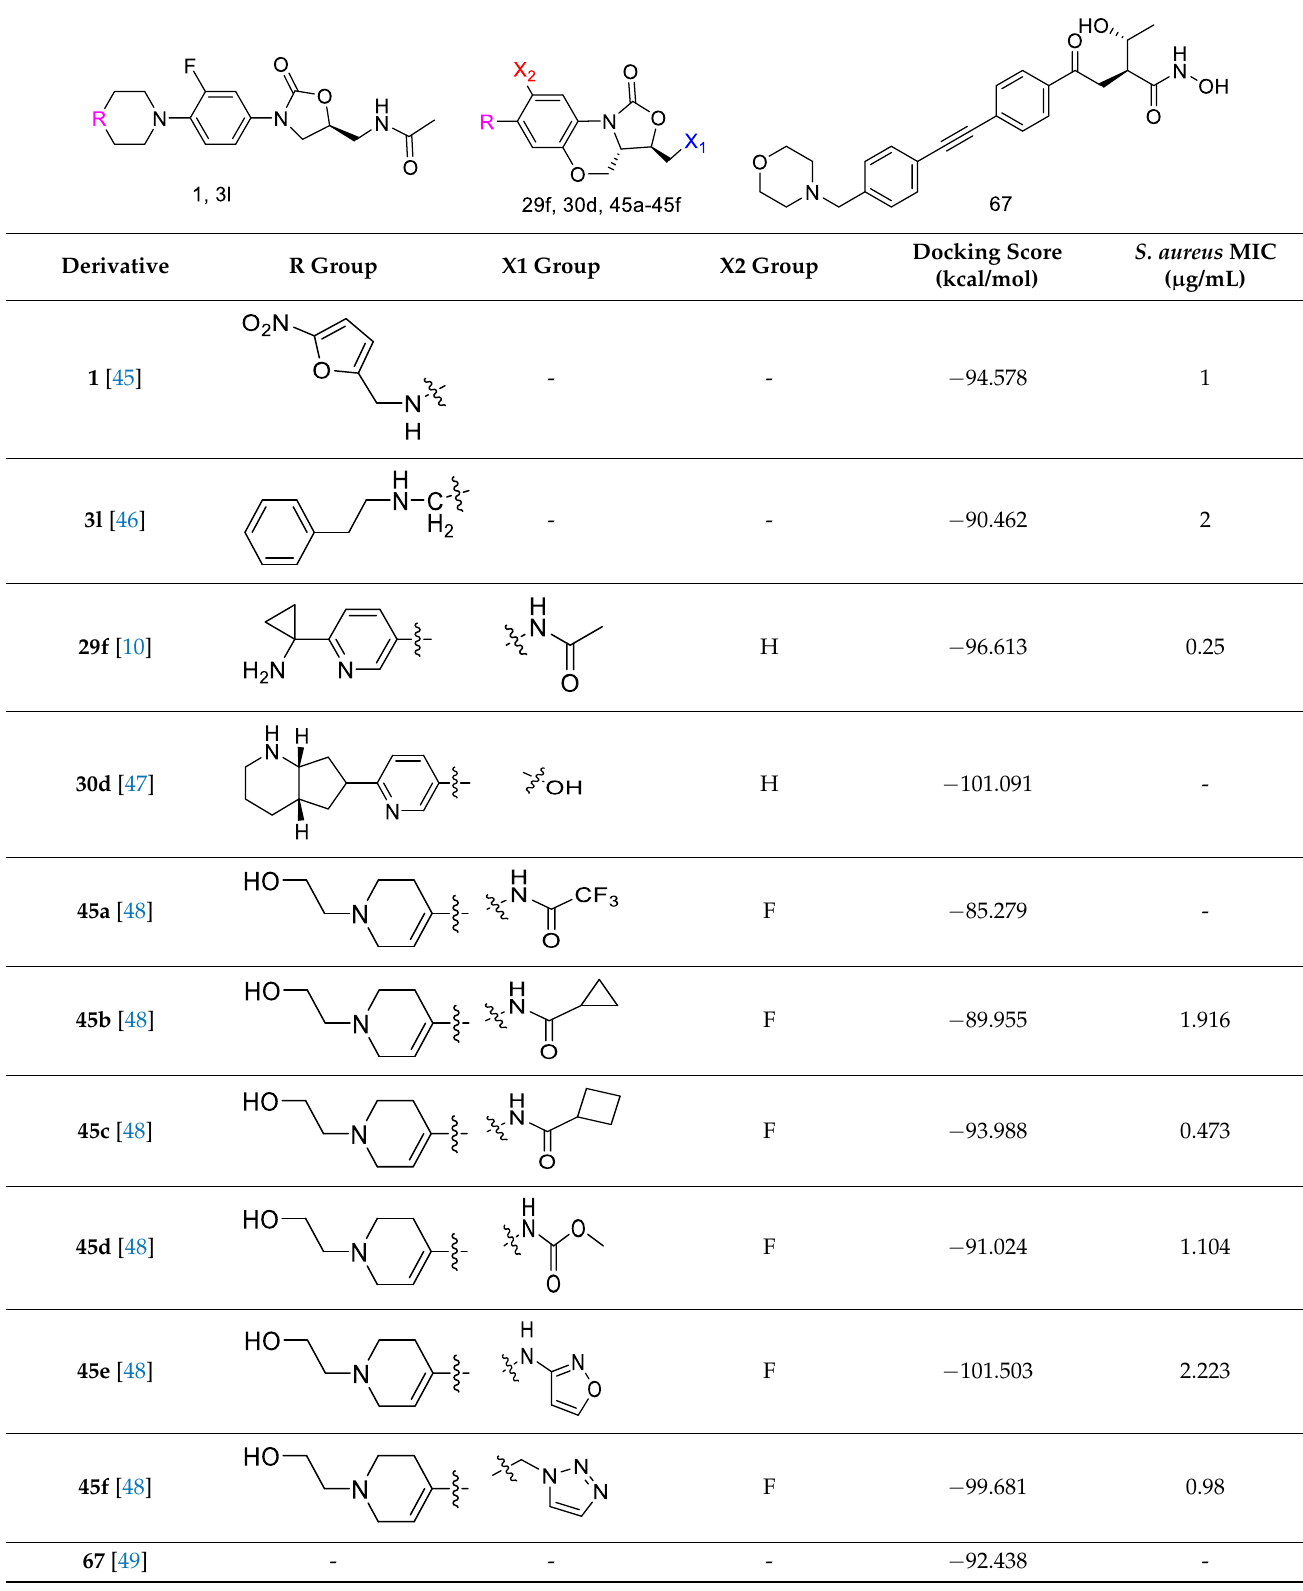
Table 2. List of derivatives determined to be the “top - performing” derivatives, with their similar base structure indicated. The structural differences are indicated by the R, X1. and X2 columns and the docking score and MIC for S. aureus .